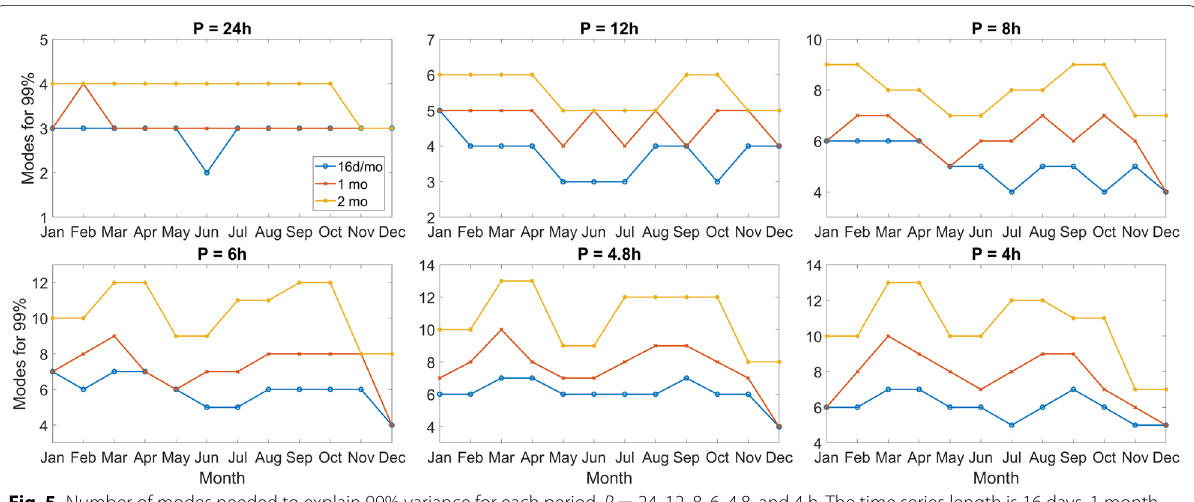
Fig. 5 Number of modes needed to explain 99% variance for each period, P 24, 12, 8, 6, 4.8, and 4 h. The time series length is 16 days, 1 month, = and 2 months (adjacent months, thus January–February, March–April, May–June, etc.). The FT segment length for all PCA runs is 24 h. Note that January and December do not have the full months of data available, as the TIE-GCM stream function spans 13.01.2009-16.12.2009